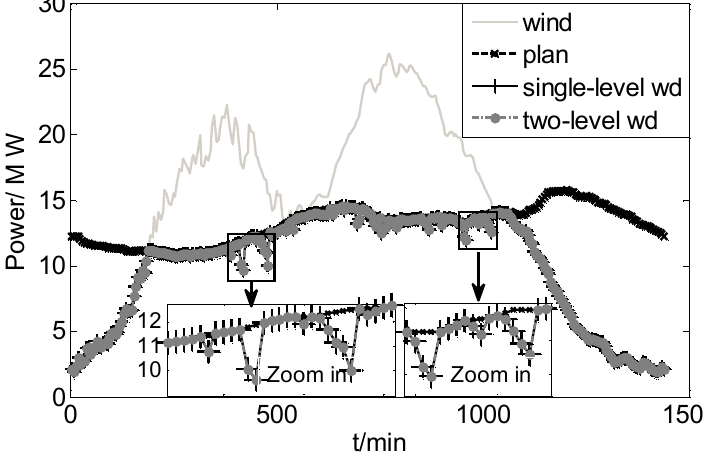
Figure 11. Simulation result for the third